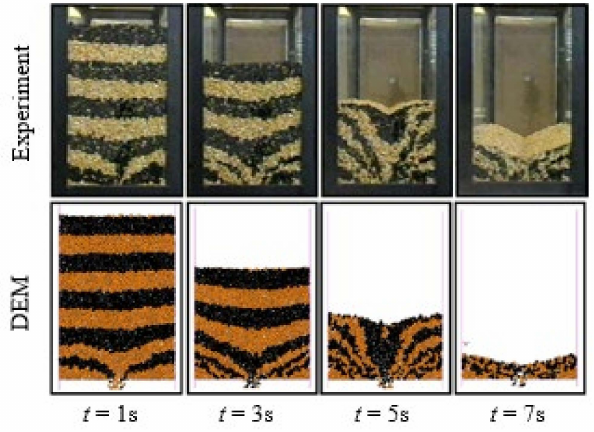
Figure 5. Test and simulation diagrams of rectangular flat-bottom silo.